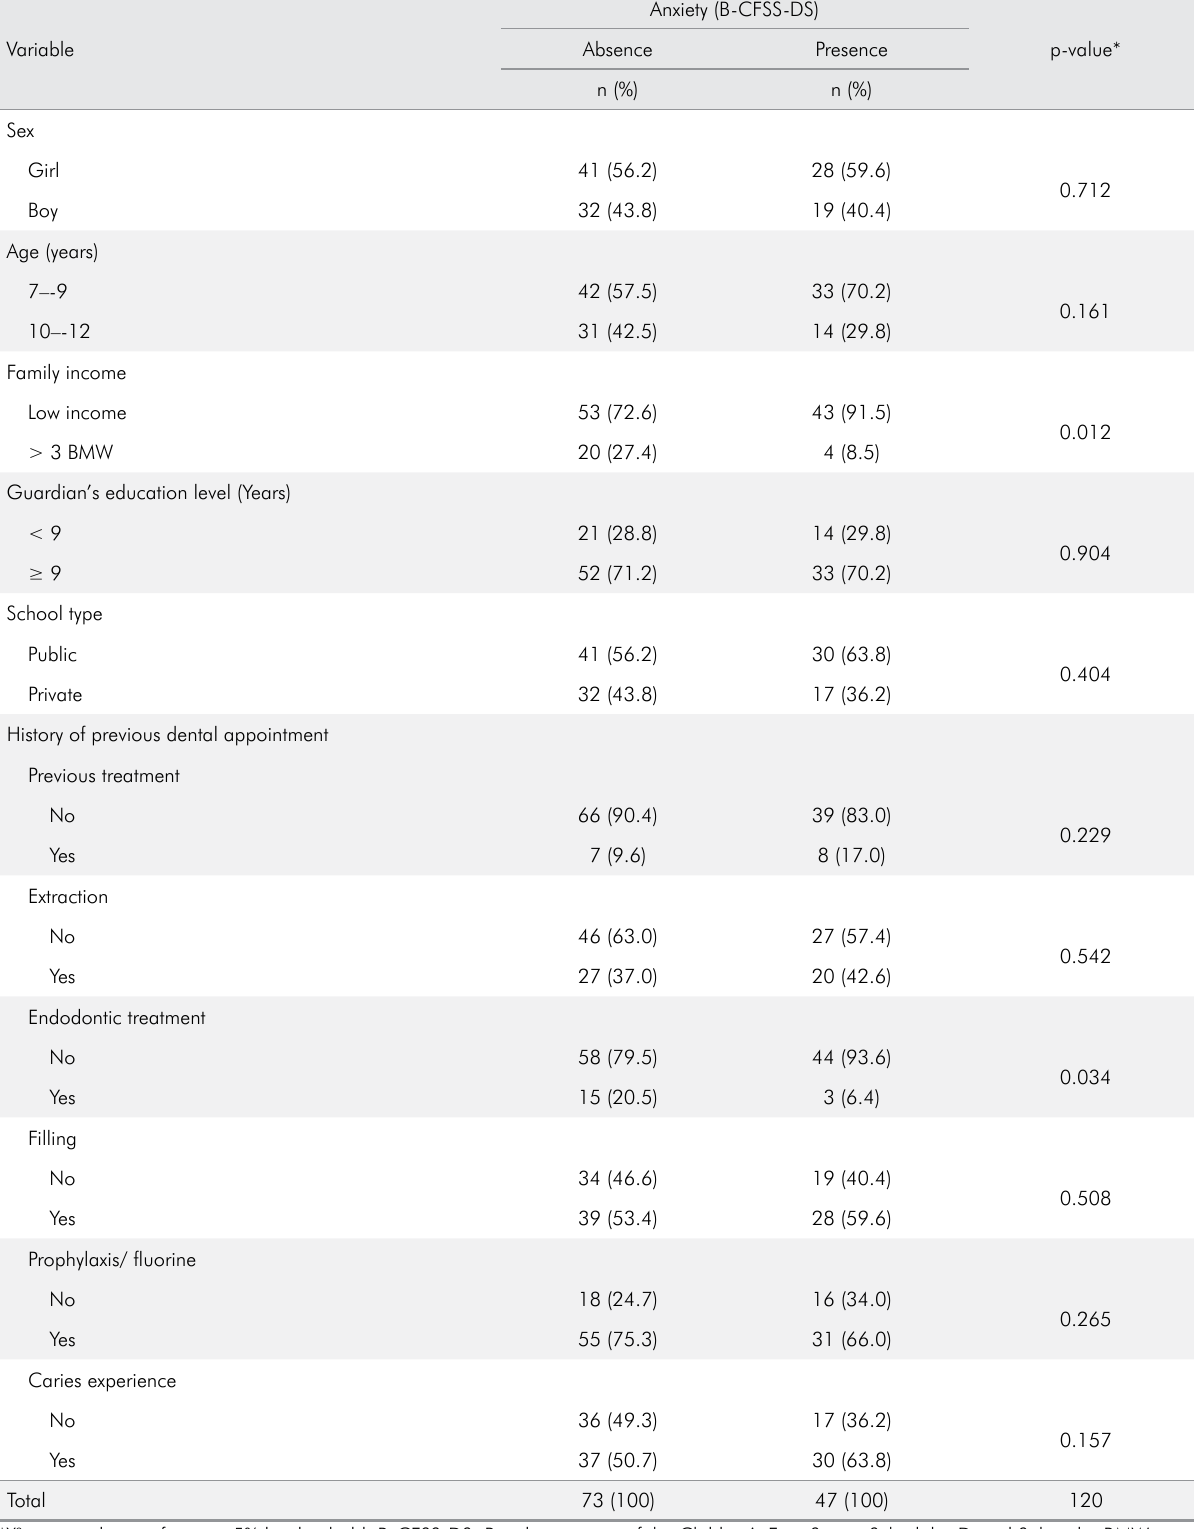
Table 2. Identification of dental anxiety between the study